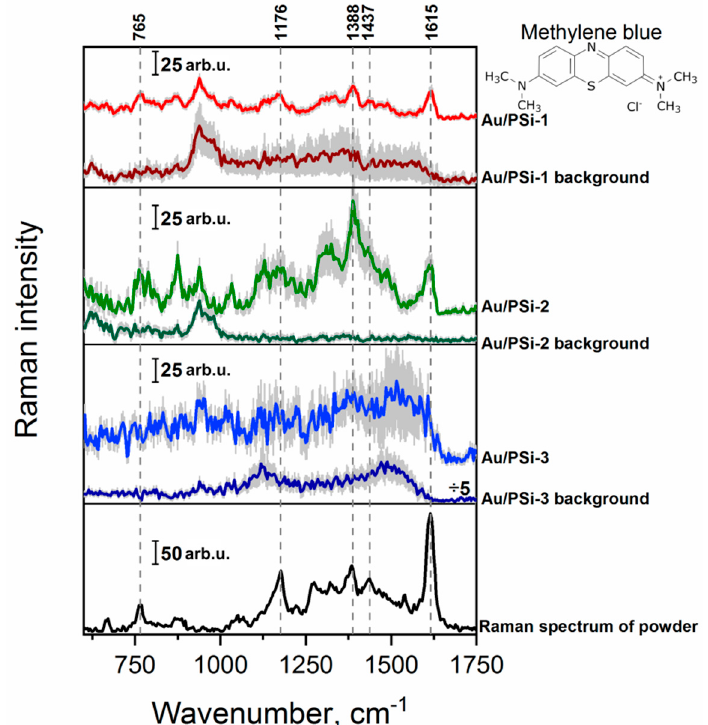
Figure 3. Raman spectrum of MB powder and mean SERS spectra of 10 − 5 M MB concentration on the surfaces with different porosity: Au/PSi-1, Au/PSi-2 and Au/PSi-3. Error scale bar (shown as grey shadow) for all presented spectra indicates the standard deviations from around 1500 measured spectra from three different areas of the substrate.